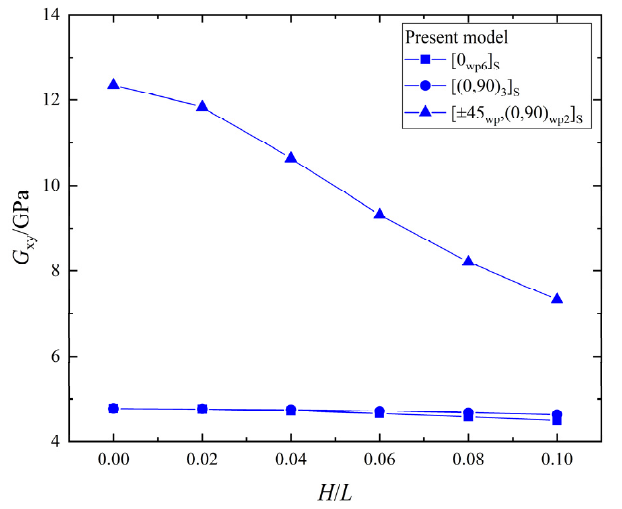
Figure 16. The shear stiffness, 𝐺